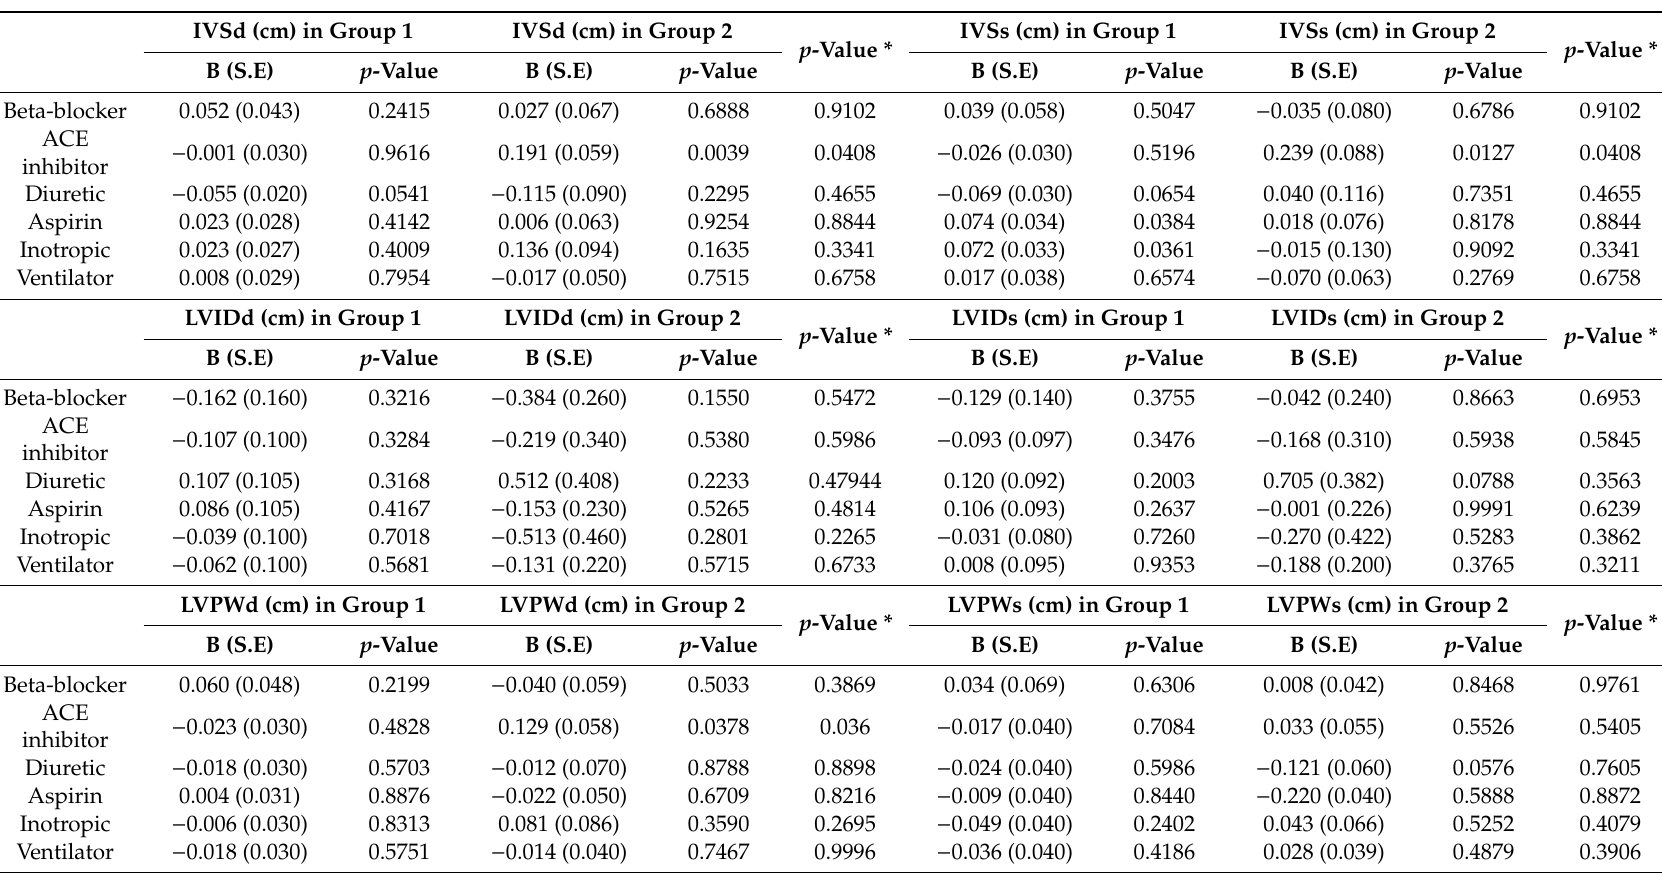
Table 6. Linear mixed model analysis of the e ff ect of cardiac medication and respiratory care on echocardiographic measurements in each